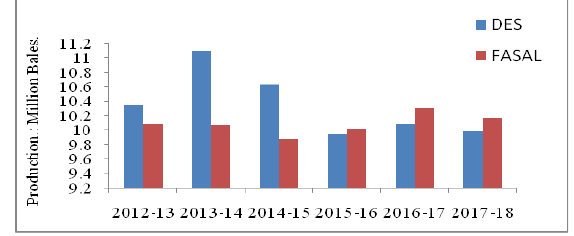
Figure 10. Comparison of Jute productionin last six years at national level